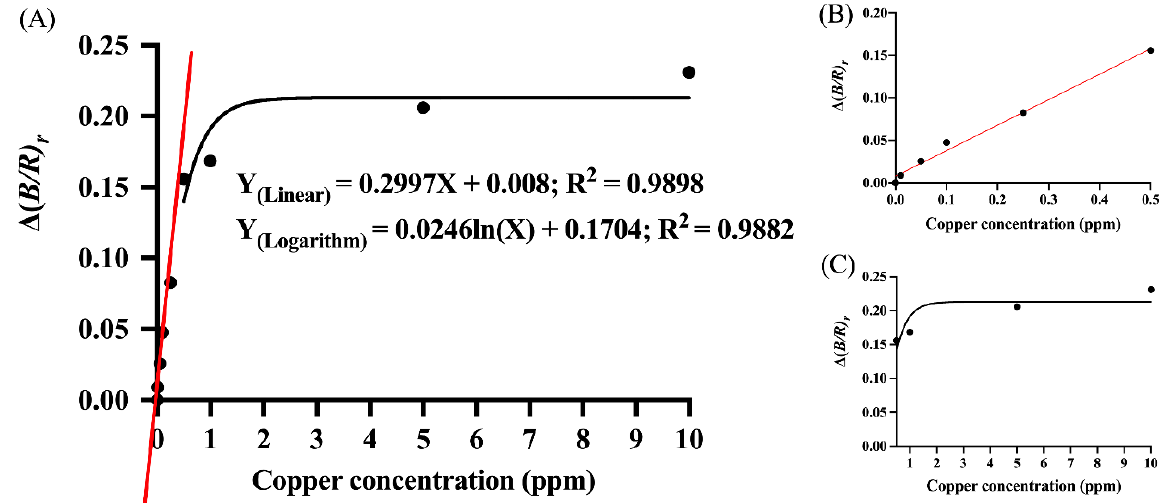
Figure 6. ( A ) The plot of Δ( B/R) r against Cu 2+ concentrations in the range of 0 – 10 ppm. The linear regression line for Cu 2+ concentrations in the range of 0.09 – 0.5 ppm is indicated with a red line. The logarithmic regression line for Cu 2+ concentrations in the range of 0.5 – 10 ppm is indicated with a black line. Insets ( B , C ) are expanded views of the linear and logarithmic regression lines, respectively. The linear and logarithmic equations along with the corresponding correlation coefficients are indicated in ( A ).